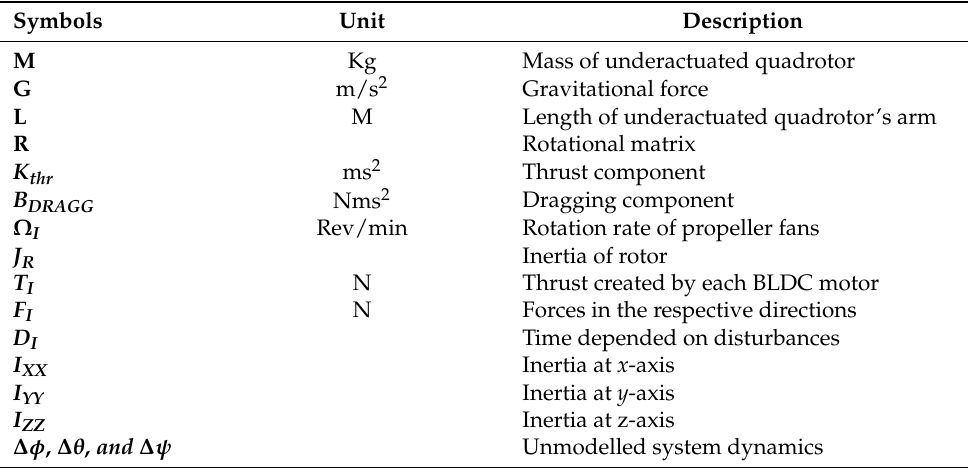
Table 1. Symbols with their brief description and